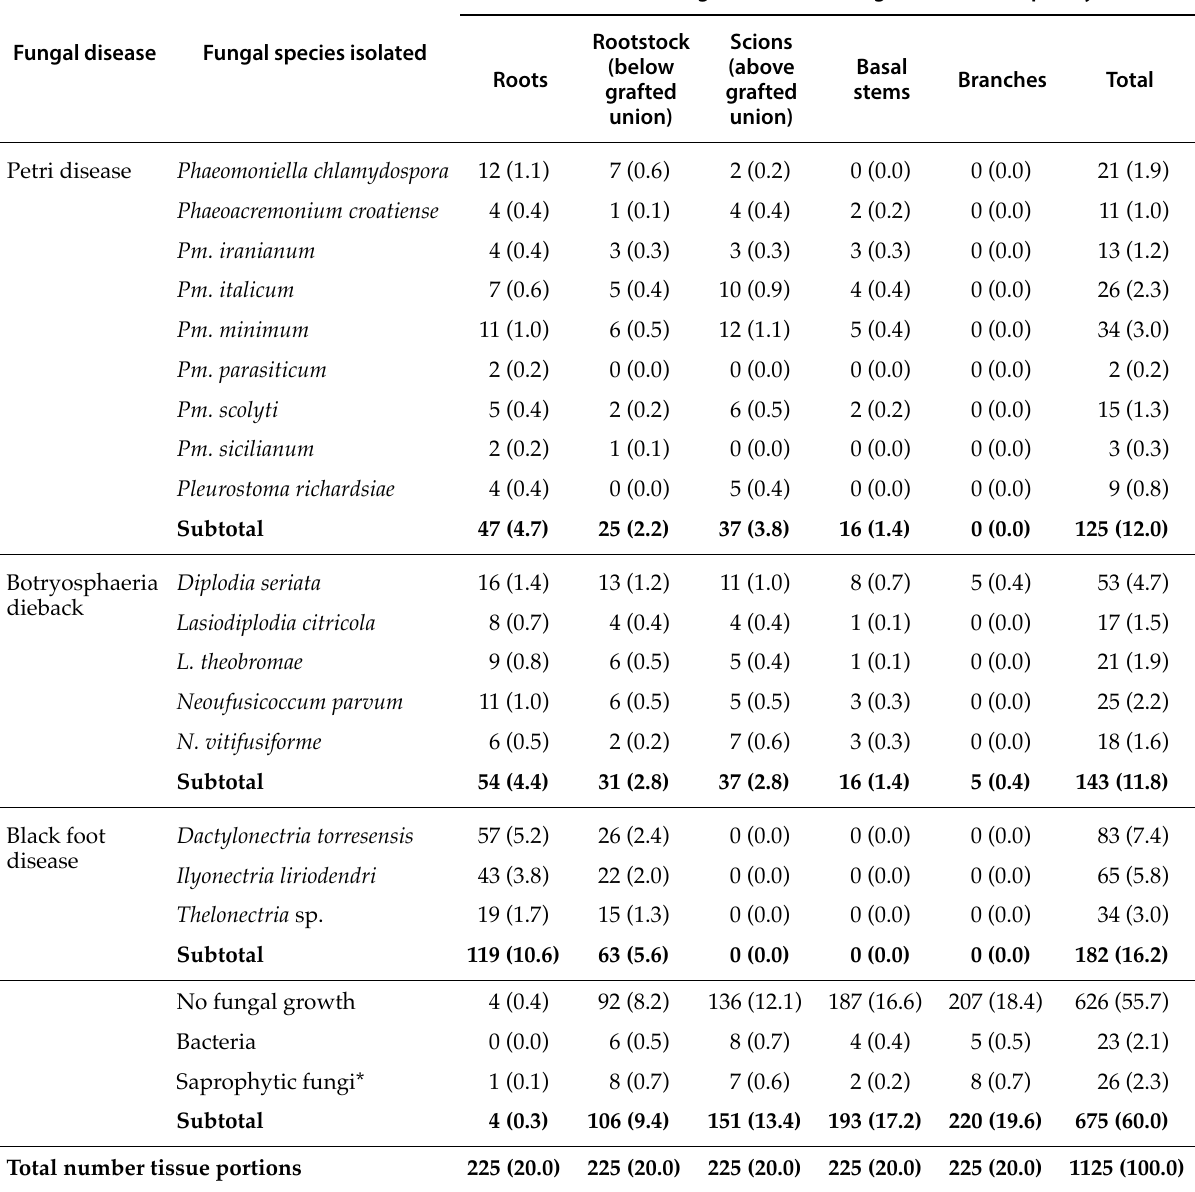
Table 3. Fungal species isolated from symptomatic grapevine samples. Fungal disease Fungal species isolated